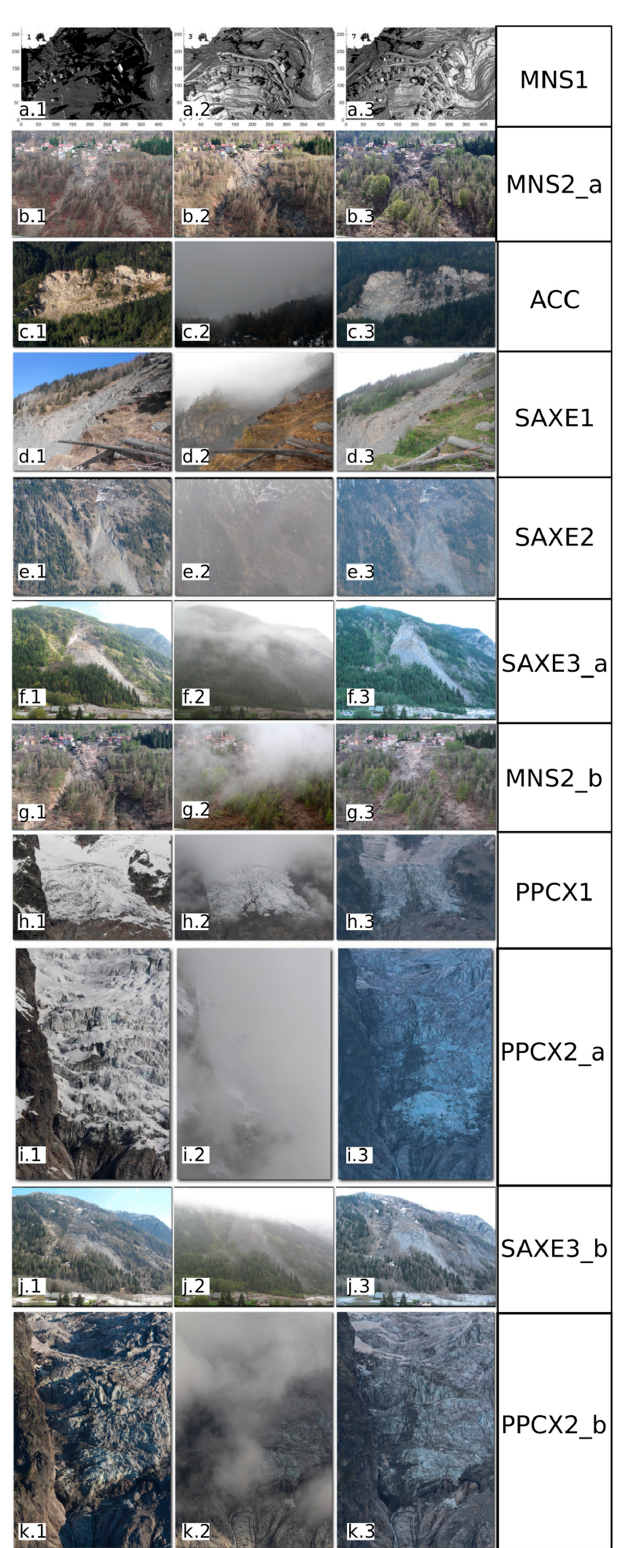
Figure 4. Examples of images taken from di ff erent datasets. Row ( a ) shows the 1st, 3rd and 7th shading reliefs with changes in the light source position; ( b.2 , b.3 ) were acquired in direct illumination at di ff erent hours of the day; and rows ( c – i ) show examples of each class from the datasets used in image classification analysis. The photographs in rows ( j , k ) were used to develop the automatic